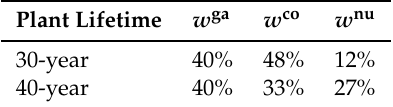
Table 10. The composition of efficient portfolios with zero expected NPV. The three-asset case. The composition is the same under both the standard deviation and the CVaR deviation risk